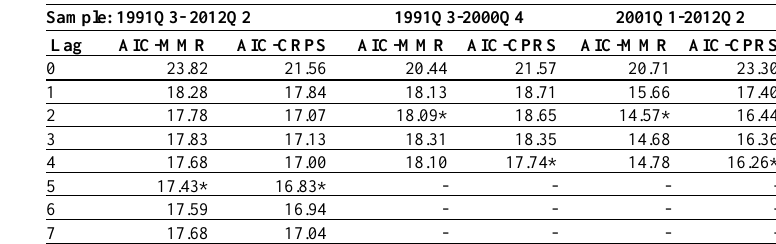
ADF Unit Root Test